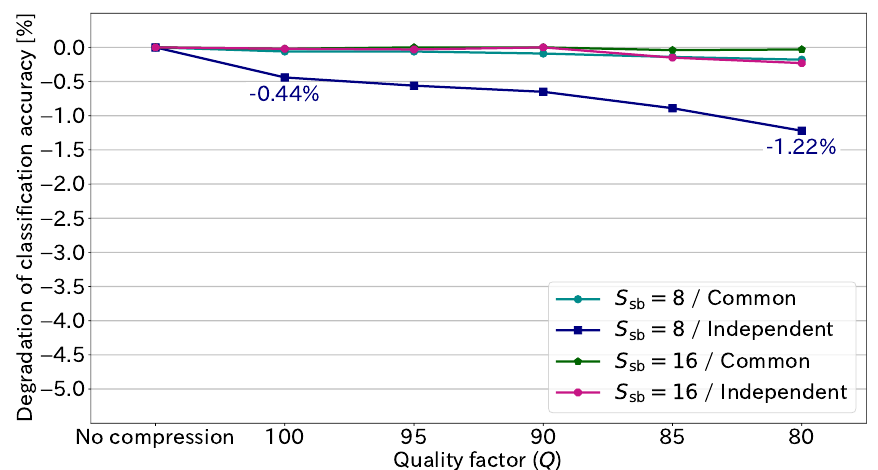
Figure 11. Degradation in classification accuracy at each quality factor.